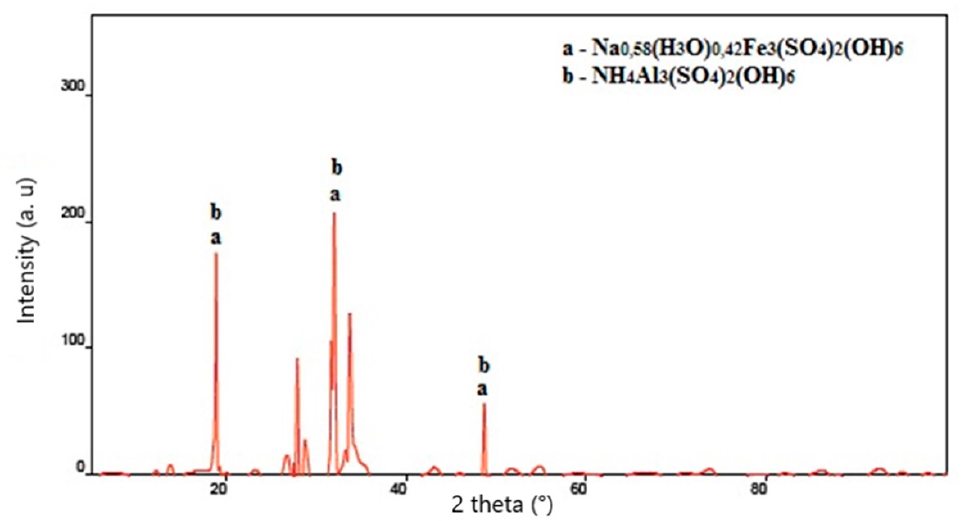
Figure 10. Precipitate XRD diffractogram formed at pH = 4 in the supercritical leachate.